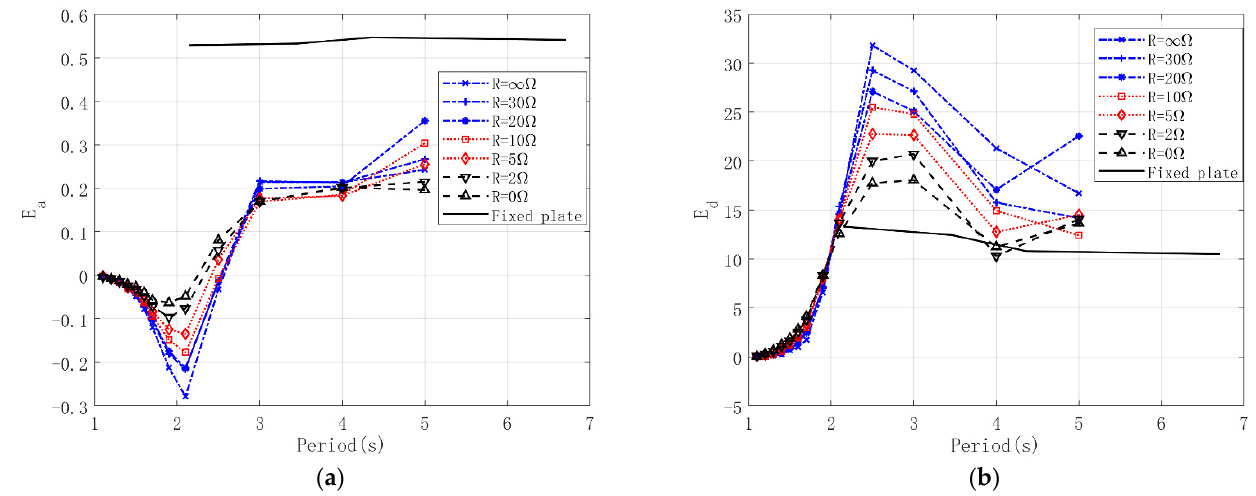
Figure 15. The equivalent hydrodynamic parameters of THP1 with different load resistance. ( a ) E a ; ( b ) E d